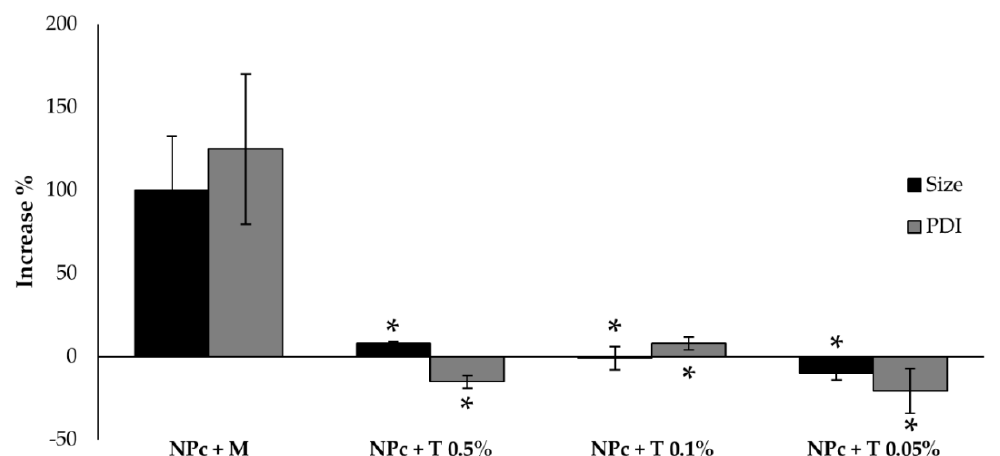
Figure 5. Changes in particle size and PDI of NPc after reconstitution of lyophilized powder containing 0.5% w/w mannitol (NPc + M), trehalose in concentration of 0.5% w/w (NPc + T 0.5%), 0.1% w/w (NPc + T 0.1%), and 0.05% w/w (NPc + T 0.05%). * p < 0.05 versus NPc + M.